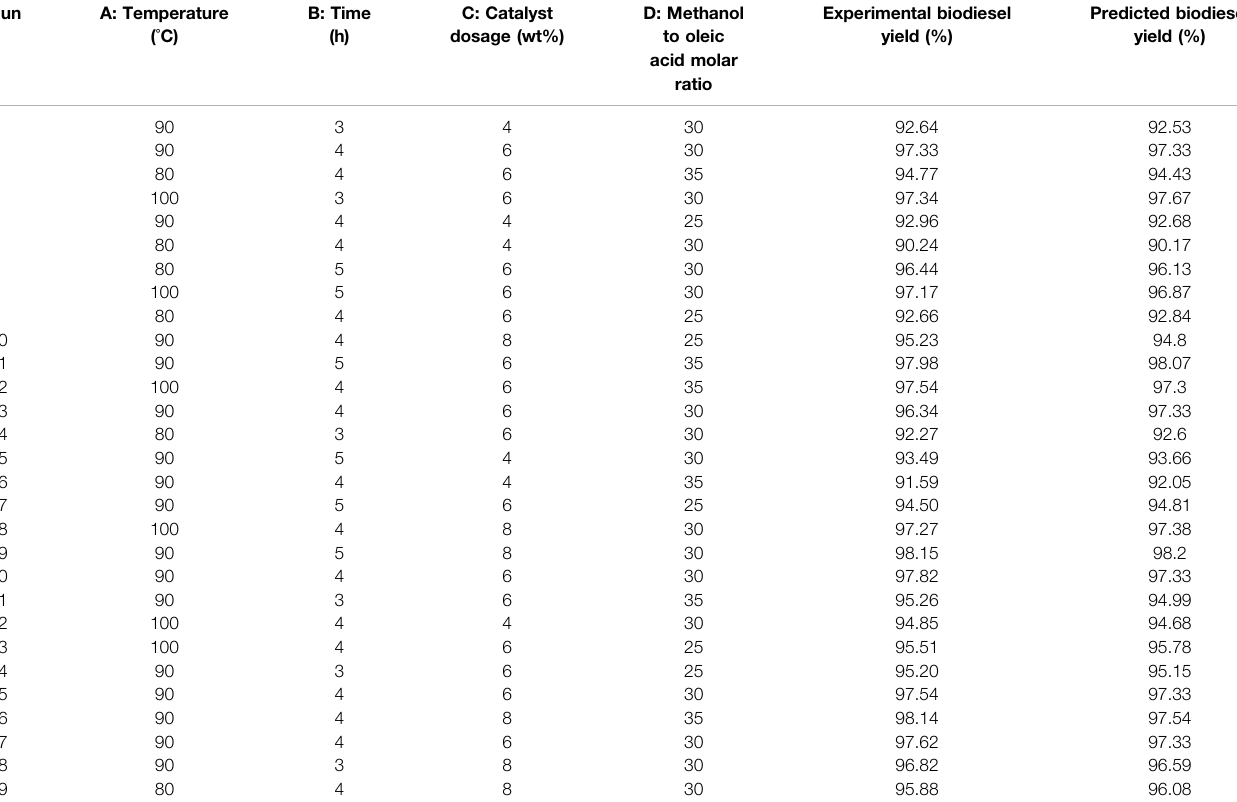
TABLE 2 | Experimental design and results of oleic acid esteri fi cation reaction catalyzed by SiO 2 @Cs-SO 3 H.